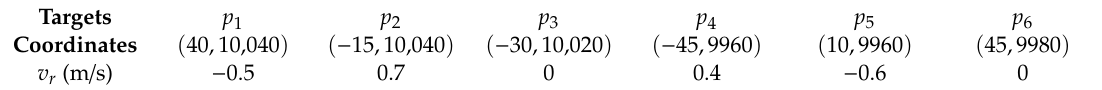
Figure 5. Distribution of false targets. Table 2. The coordinates and velocity of the false point target.